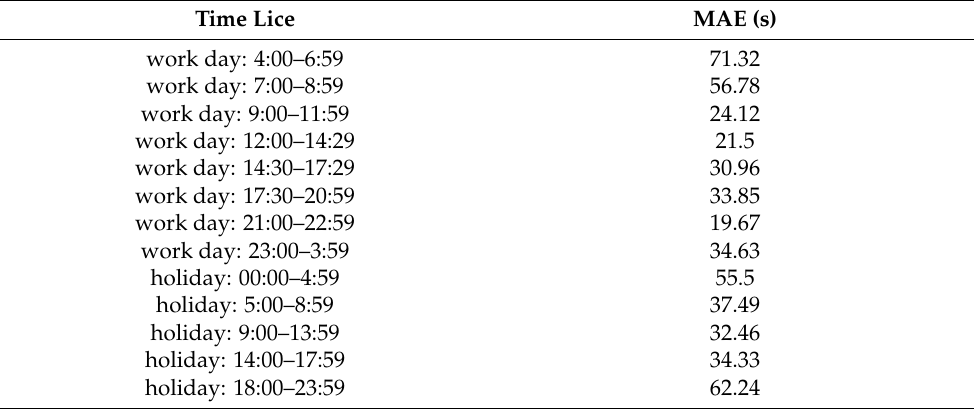
Table 7. MAE value of each time